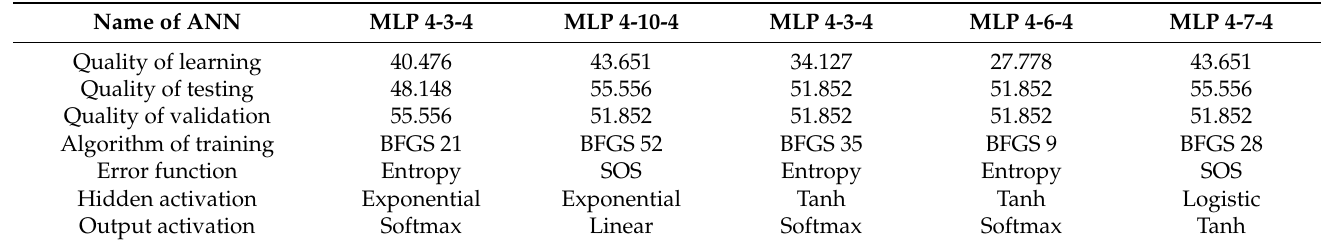
Table 1. Results of learning artificial neural networks created in Statistica 13.3, together with pa- rameters of the best models created for the four-class classification on the basis of GLCM features